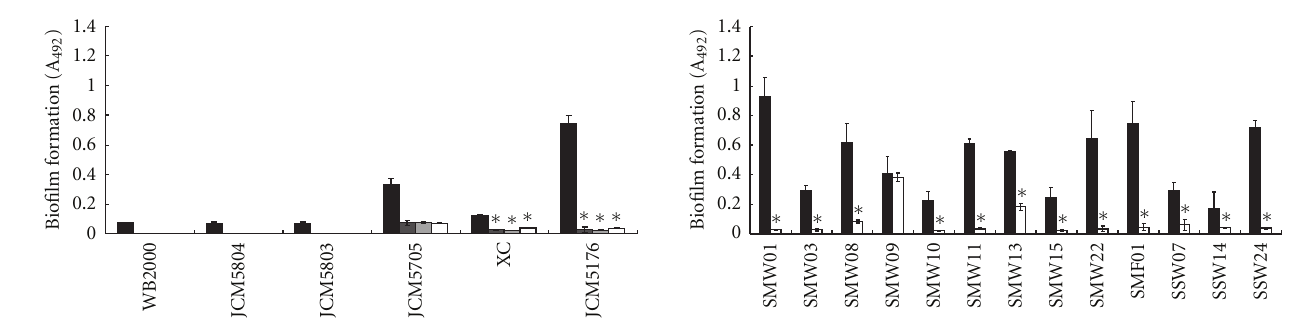
Figure 1: Inhibitory e ff ects of E. faecium WB2000 and JCM5804 and E. faecalis JCM5803 on biofilm formation by laboratory mutans group streptococci. WB2000, E. faecium WB2000; JCM5804, E. fae- cium JCM5804; JCM5803, E. faecalis JCM5803; JCM5705, S. mutans JCM5705; Xc, S. mutans Xc; JCM5176, S. sobrinus JCM5176. Black bars: single culture; dark gray bars: dual culture with E. faecium WB2000; light gray bars: dual culture with E. faecium JCM5804; white bars: dual culture with E. faecalis JCM5803. ∗ P < 0 . 05 versus single culture.